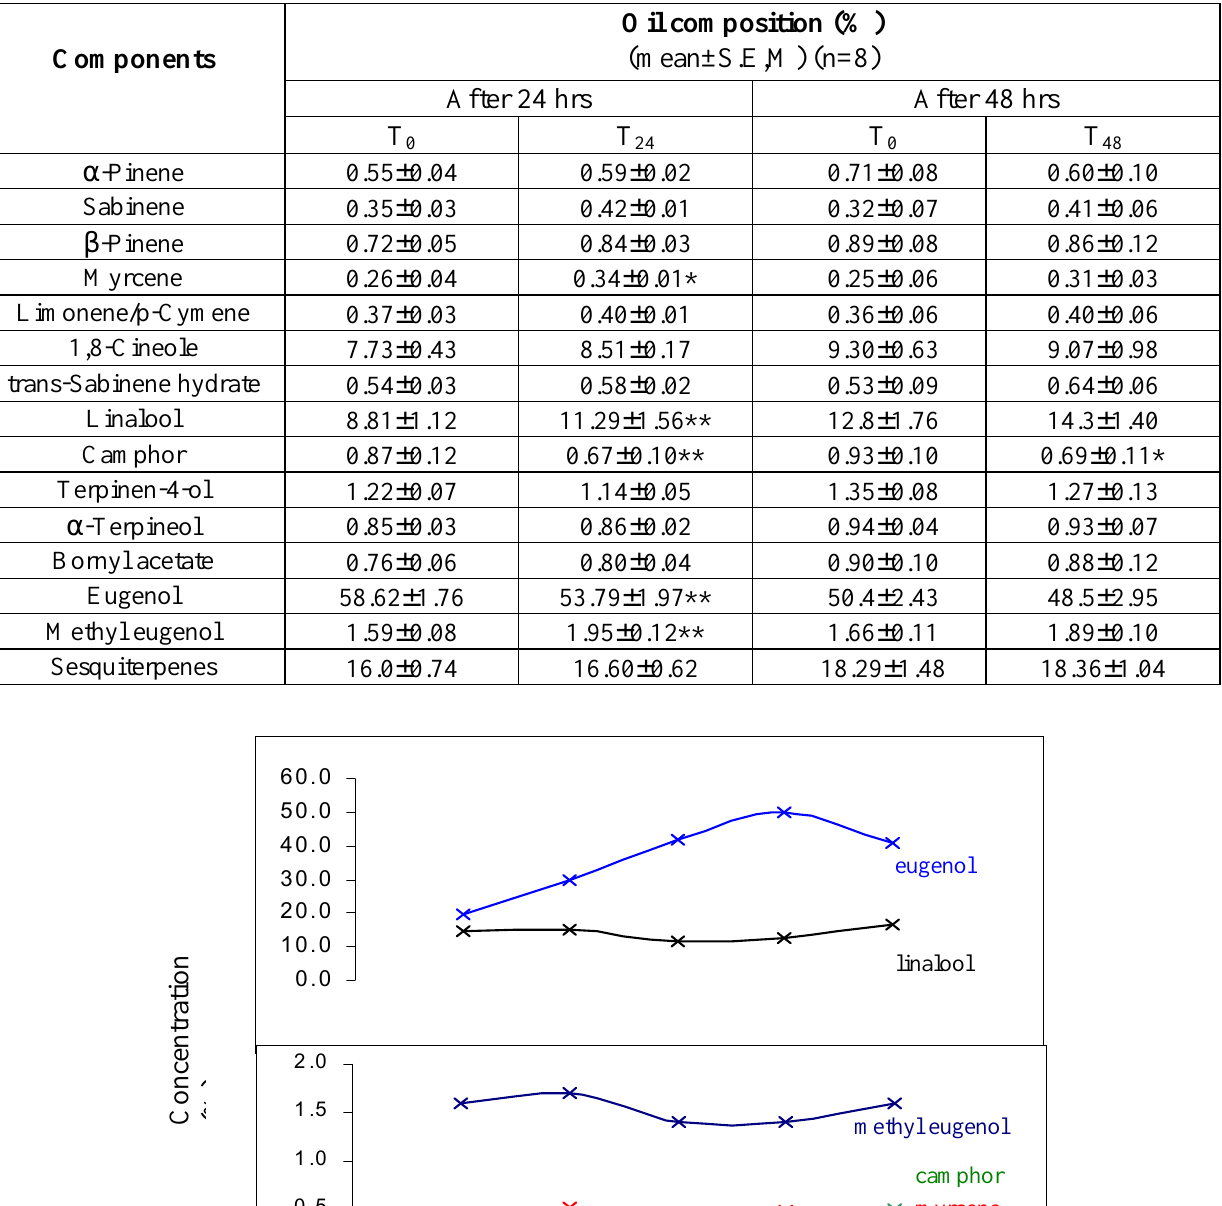
Table 1 . Effect of mechanical damage on oil composition of selected components in O. minimum leaves. Constituents with a concentration greater than 0.2% are shown. Asterisks indicate statistical significance of the difference between T and T values for that component within the same 0 24 experiment (* at p <0.05; ** at p <0.02, Wilkoxon signed-ranks test, S.E.M = standard error of the mean).